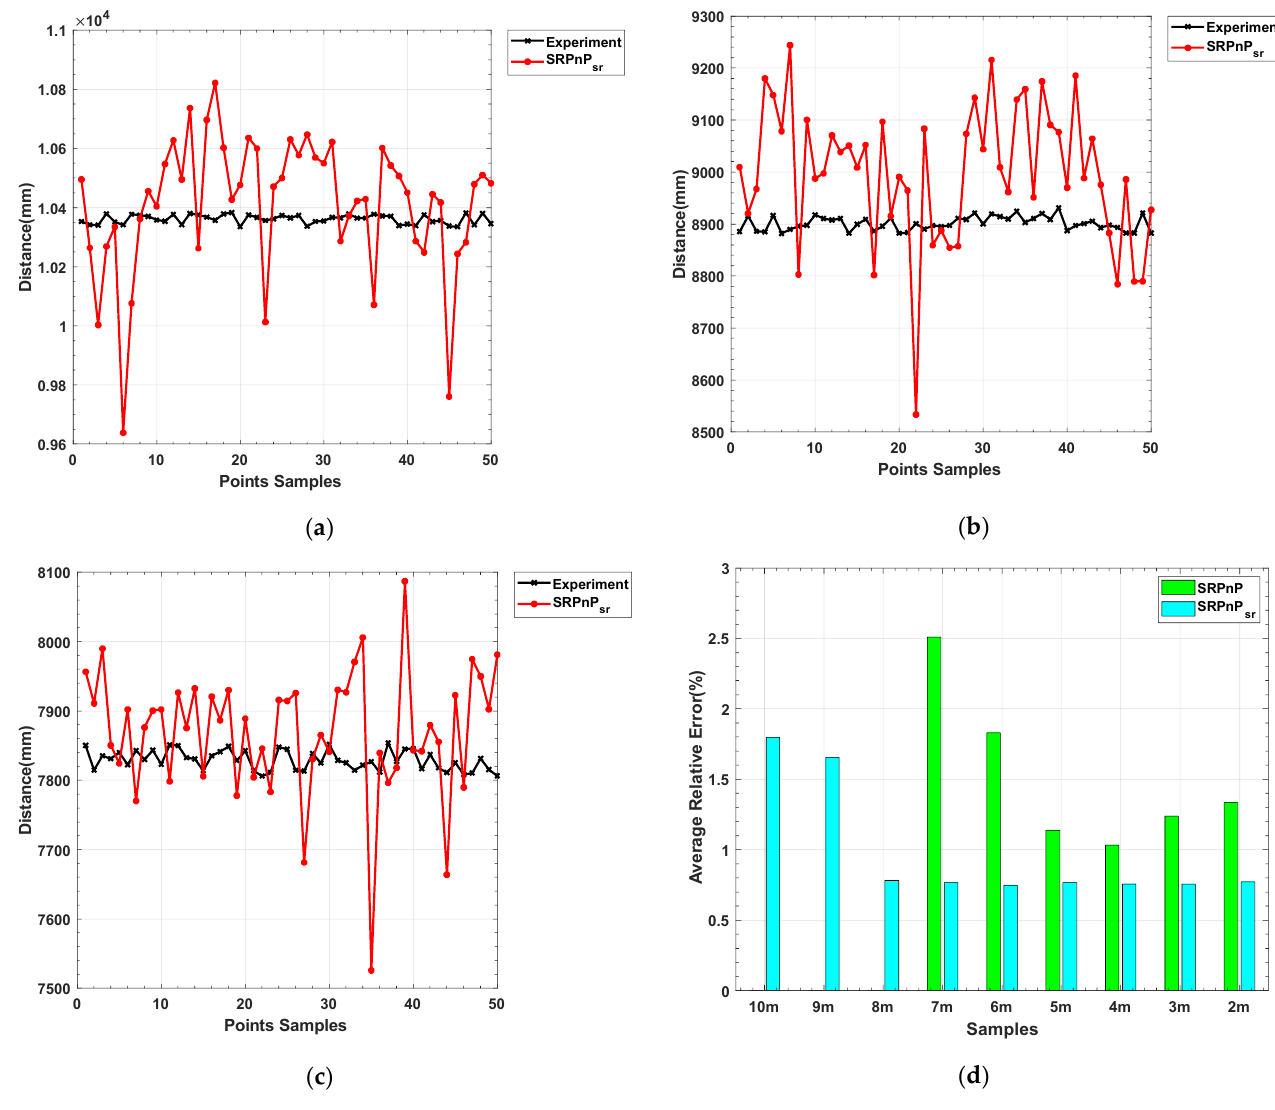
Figure 18. Ranging results are based on super-resolution image enhancement and a subpixel centroid localization method: ( a ) Detection results of optical beacons within 10 m; ( b ) Detection results of optical beacons within 9 m; ( c ) Detection results of optical beacons within 8 m; ( d ) The average relative error of